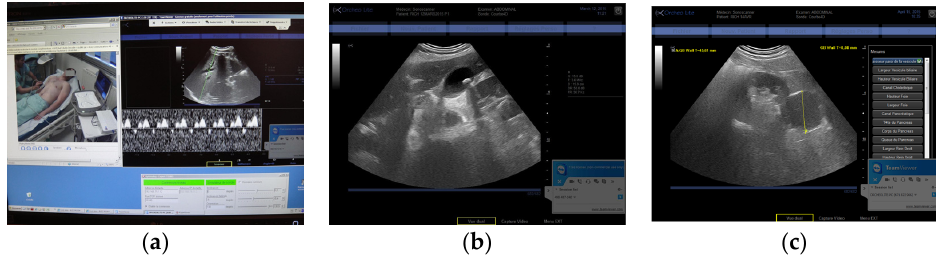
Figure 4. ( a ) Expert center computer screen for the MP with video of the patient (left), hepatic vein Doppler (right), and probe engine interface (bottom right); ( b ) View of gallbladder with lithiasis inside; ( c ) View of a renal cyst.